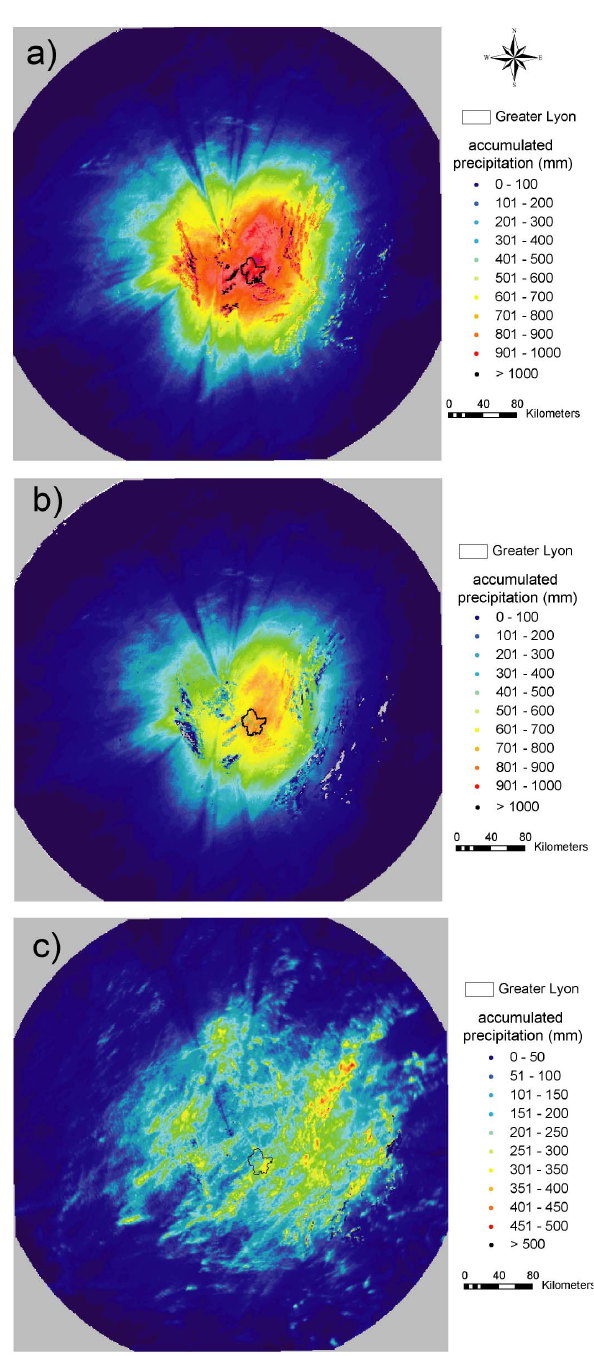
Fig. 3. a and b: accumulated precipitation of 17 rainfall events from July 2001 to July 2005 (a) 11329 reflectivity images converted with Marshall-Palmer, 1948; (b) 3673 Hydram rain accumulation images; (c) July 2008 accumulated precipitation for 8928 Panthere rain accumulation